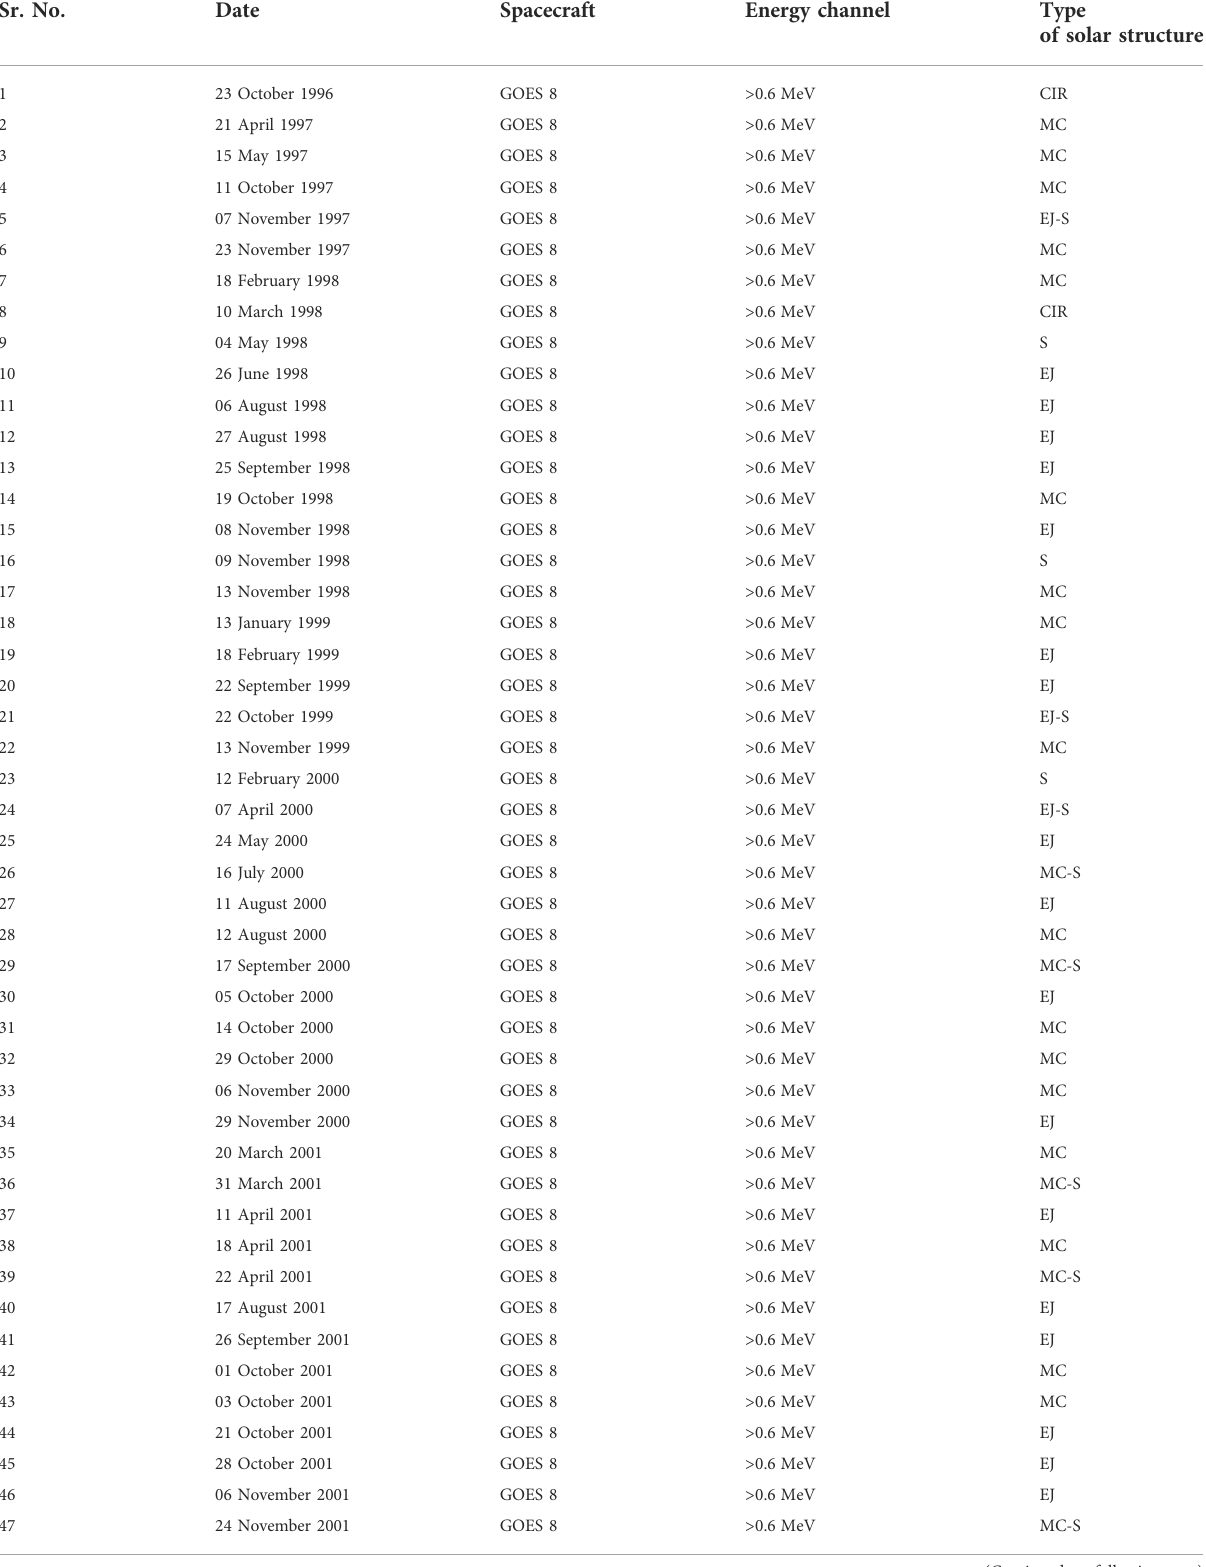
TABLE 1 List of events considered in this study along with the GOES spacecraft, the energy channel used, and the type of solar structure associated. Sr.